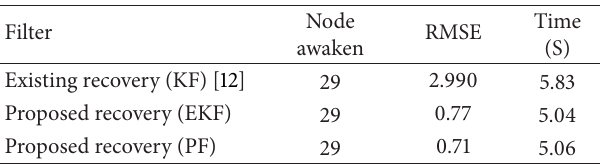
Table6:Performancecomparison:communicationfailure—CaseII